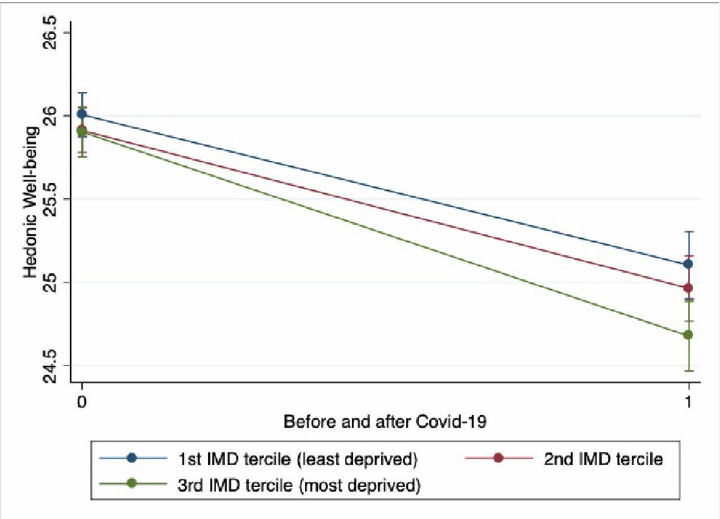
Fig 2. Change in Hedonic Well-being across the Covid-19 outburst by neighbourhood deprivation terciles. Authors computation on Understanding Society.